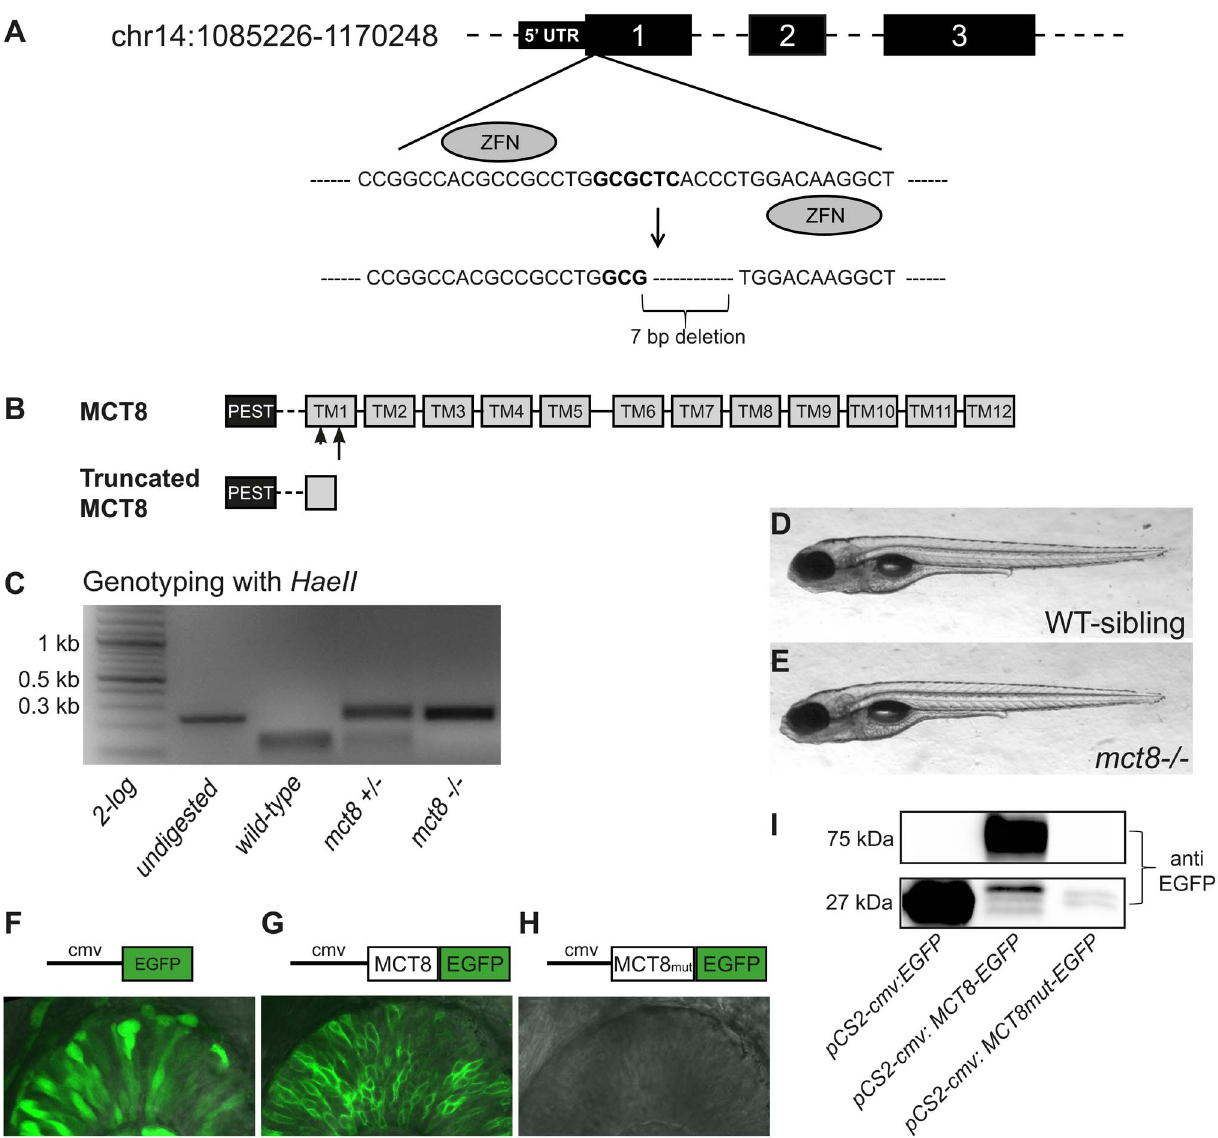
Figure 1. Establishment of ZFN-mediated mct8 zebrafish mutant. A . A pair of ZFNs was designed to target the HaeII restriction site (bold) within the first axon of the zebrafish mct8 gene located on chromosome 14. The targeted mutation resulted in a 7 bp deletion. B . The zebrafish MCT8 protein is schematically shown in the upper panel (TM – transmembrane domain). Arrowhead represent the location of the ZFN-mediated deletion and arrow represent the location of the premature stop codon. The truncated MCT8 protein is shown in the lower panel. C . Genotyping of WT, mct8 + / 2 , and mct8 2 / 2 embryos. Genomic DNA was amplified, and the 234 bp PCR product (left lane) was digested with HaeII restriction enzyme. Complete digestion of WT DNA resulted in two short fragments of 104 bp and 130 bp. An intact 234 bp DNA fragment is shown in mct8 2 / 2 fish, confirming the introduction of a mutation at the target site. Heterozygous fish exhibit three DNA fragments, indicating both mutated and intact mct8 alleles. D, E . Lateral view of representative 6 dpf WT-sibling and mct8 2 / 2 larvae. F–H . Upper panel: schematic illustration of the pCS2-cmv:EGFP ( F ), pCS2-cmv:MCT8-EGFP ( G ) and pCS2-cmv:MCT8mut-EGFP ( H ) DNA constructs. Lower panel: lateral view of the eye in 30 hpf embryo-injected with EGFP ( F ), MCT8-EGFP ( G ) and MCT8mut-EGFP ( H ) mRNA. I . Western blotting using antibody against EGFP. The 27 kDa band represent EGFP and the 72 kDa band represent the fusion protein MCT8-EGFP. Notably, MCT8mut-EGFP protein was not detected.